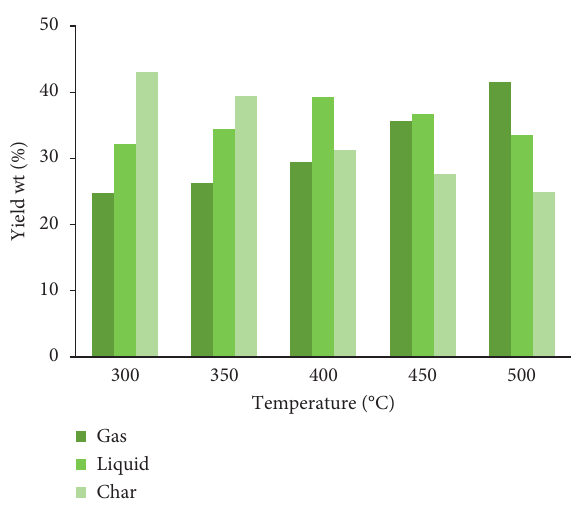
Figure 3: Effect of temperature on pyrolysis product yield.